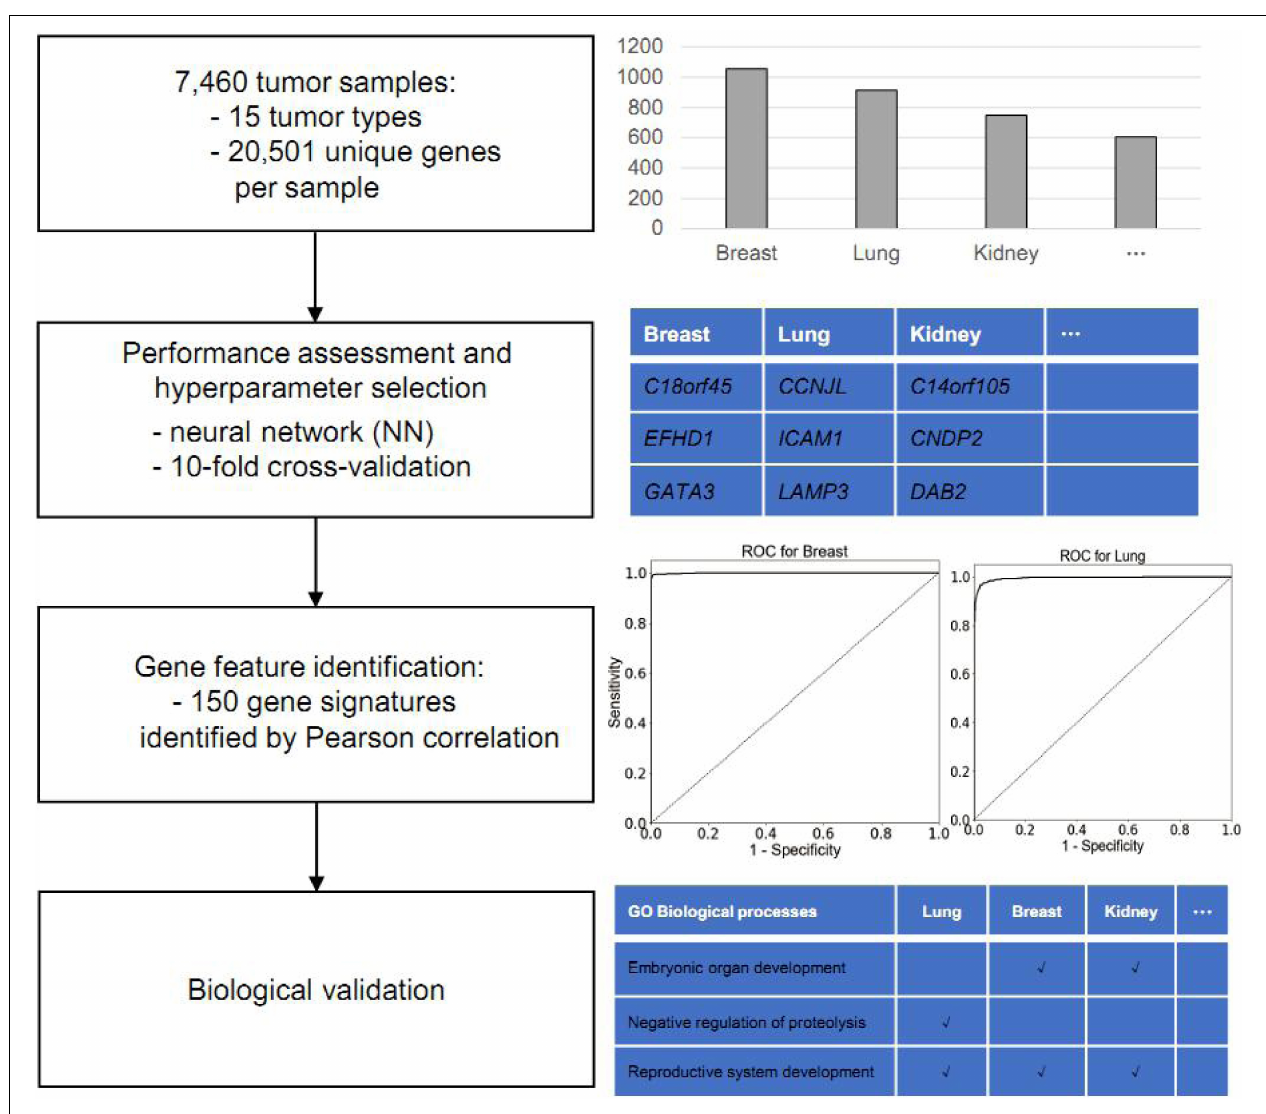
FIGURE 1 | Workflow of gene-feature identification and performance